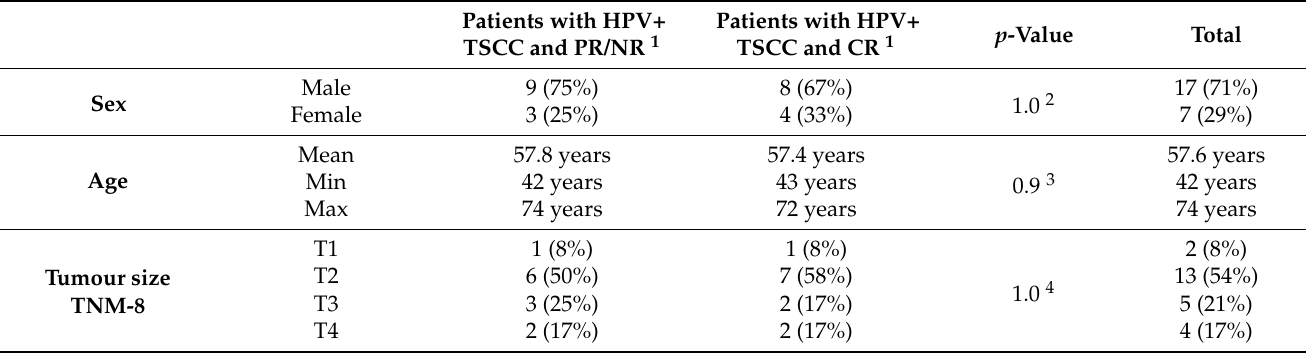
Table 1. Patients included in the first test set and their tumour characteristics. Patients with HPV+ Patients with TSCC and PR/NR 1